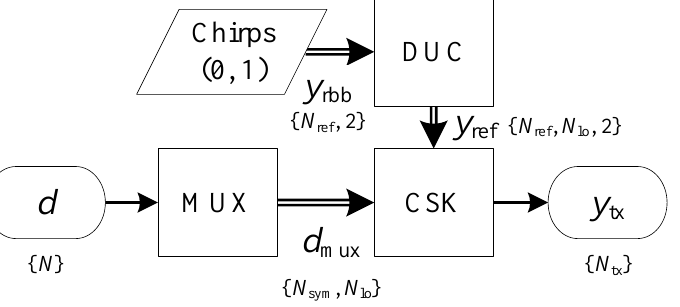
Figure 2. Modulator block in detail: The data input d is mapped onto N lo sub-bands through a multi- plexer (MUX) and modulated by the up-converted chirped symbols from the DUC. The transmission sequence y tx is assembled by the CSK block, already in the transmission band. Simple arrow lines indicate vectors, double lines